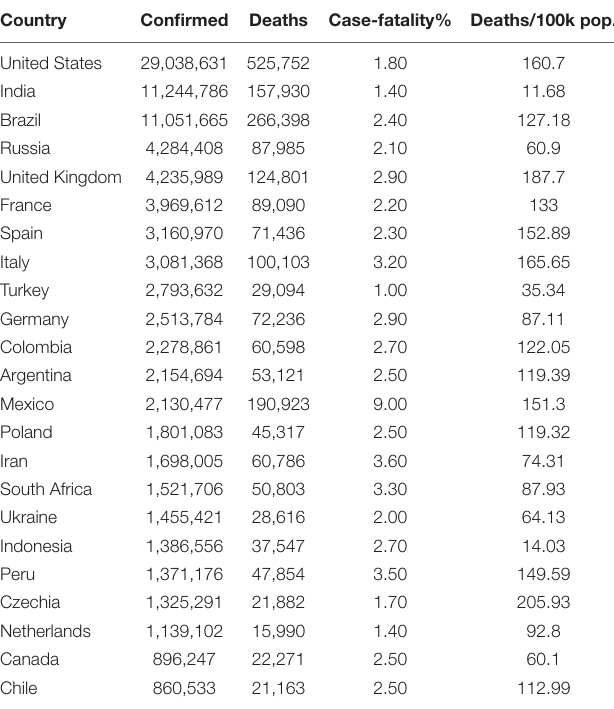
TABLE 1 | COVID-19: Confirmed infected cases, and mortality ratio (most affected countries) by March 9, 2021. Country Confirmed Deaths Case-fatality% Deaths/100k